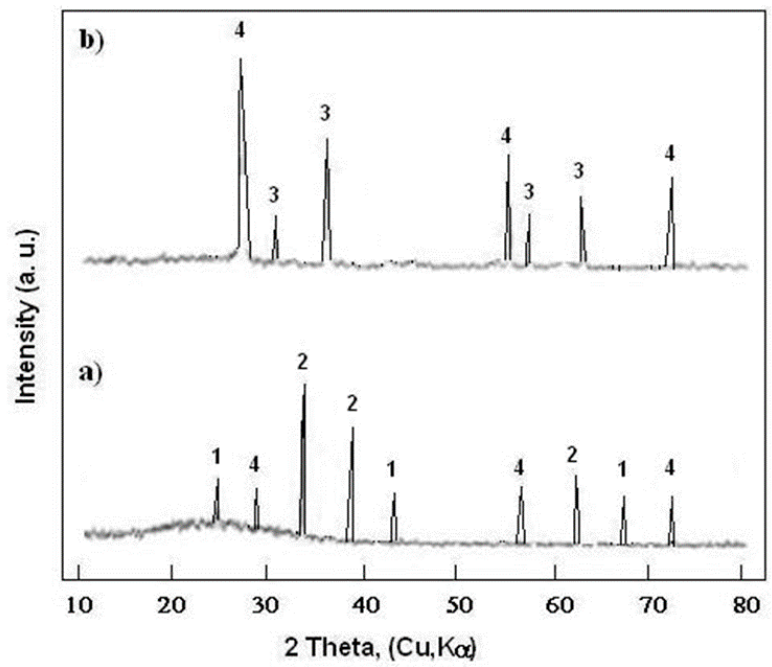
Figure 6. X-ray diffraction of the S355 steel surface after heat treatment in air atmosphere at: ( a ) 400 °C and ( b ) 800 °C. 1—FeO, 2—Fe 2 O 3 , 3—Fe 3 O 4 , and 4—graphite.